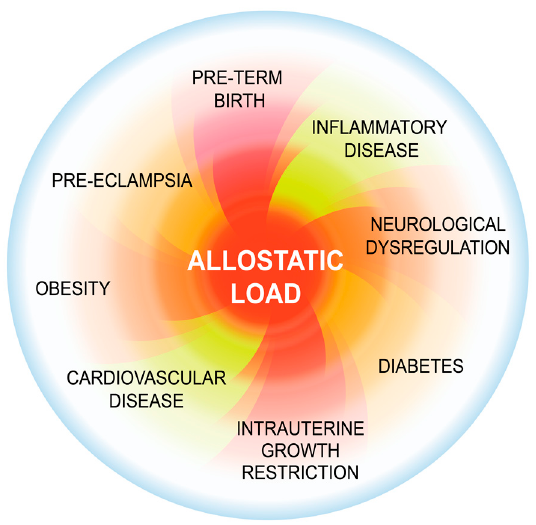
Figure 1. Allostatic load (AL) increases the risk for several perinatal and adult disease processes. Allostatic load comprises the wear and tear of stress over a lifetime on the body [1,2]. In chronic stress, the allostatic load increases as the body attempts to cope with stressors. When resiliency is overcome, inflammatory processes and neuroendocrine mediators, (e.g., cortisol and epinephrine) that normally maintain homeostasis now have a negative effect on the body, resulting in increased risk for numerous AL disease processes including preterm birth (PTB).